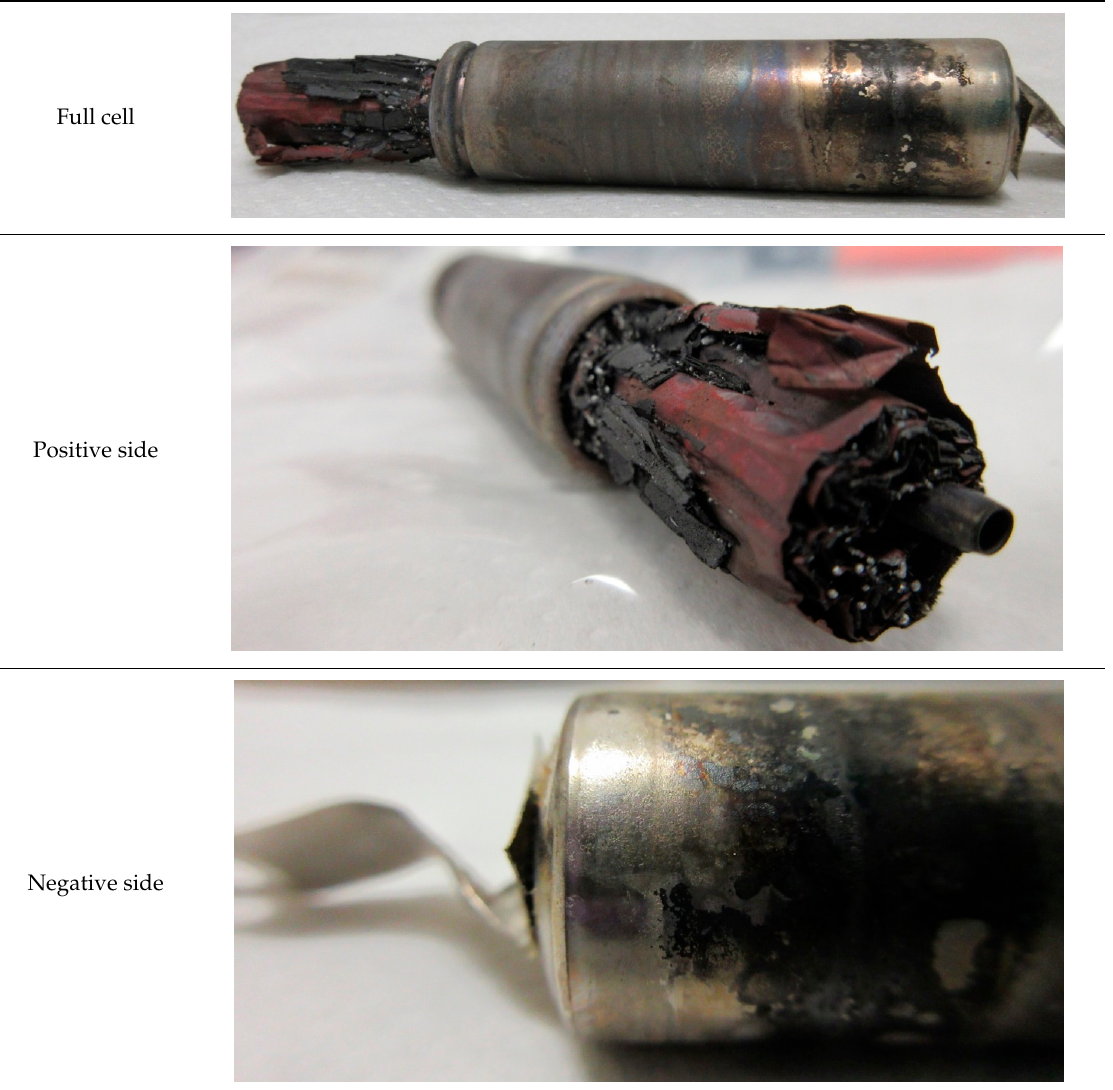
Table A4. Thermally abused Panasonic NCR GA at 50% SOC.